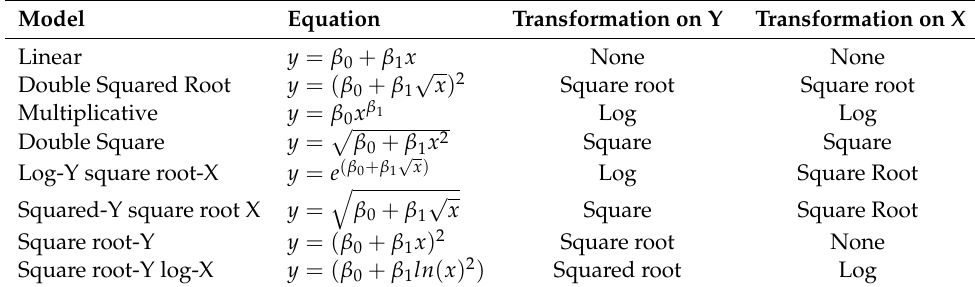
Table 3. Models used in our